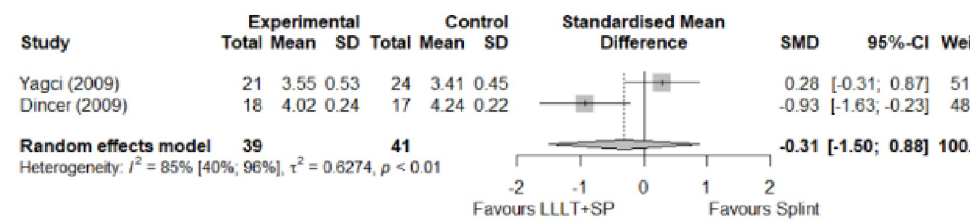
Fig 31. Analysis—Low-level laser plus splint versus splinting (motor latency).